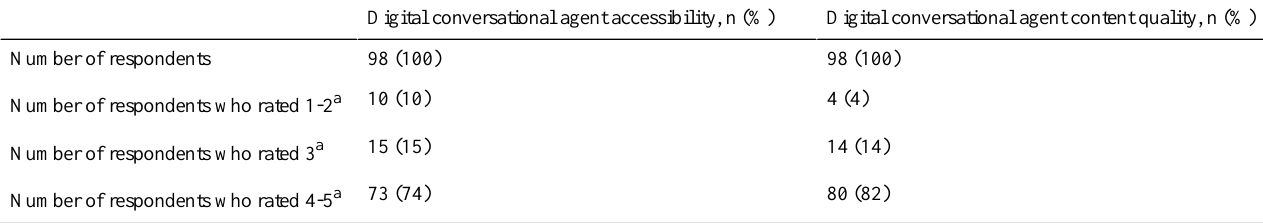
Table 3. Digital conversational agent users’satisfaction analysis (n=98).